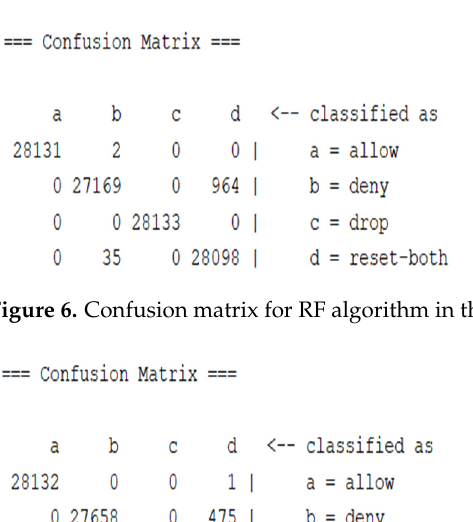
Figure 5. Comparison between the achieved accuracy for all classifiers in the second experiment. To get a better evaluation, the confusion matrix was considered. Figures 6 and 7 show the confusion matrix when using the RF classifier, showing the number of correctly classified instances for both experiments.